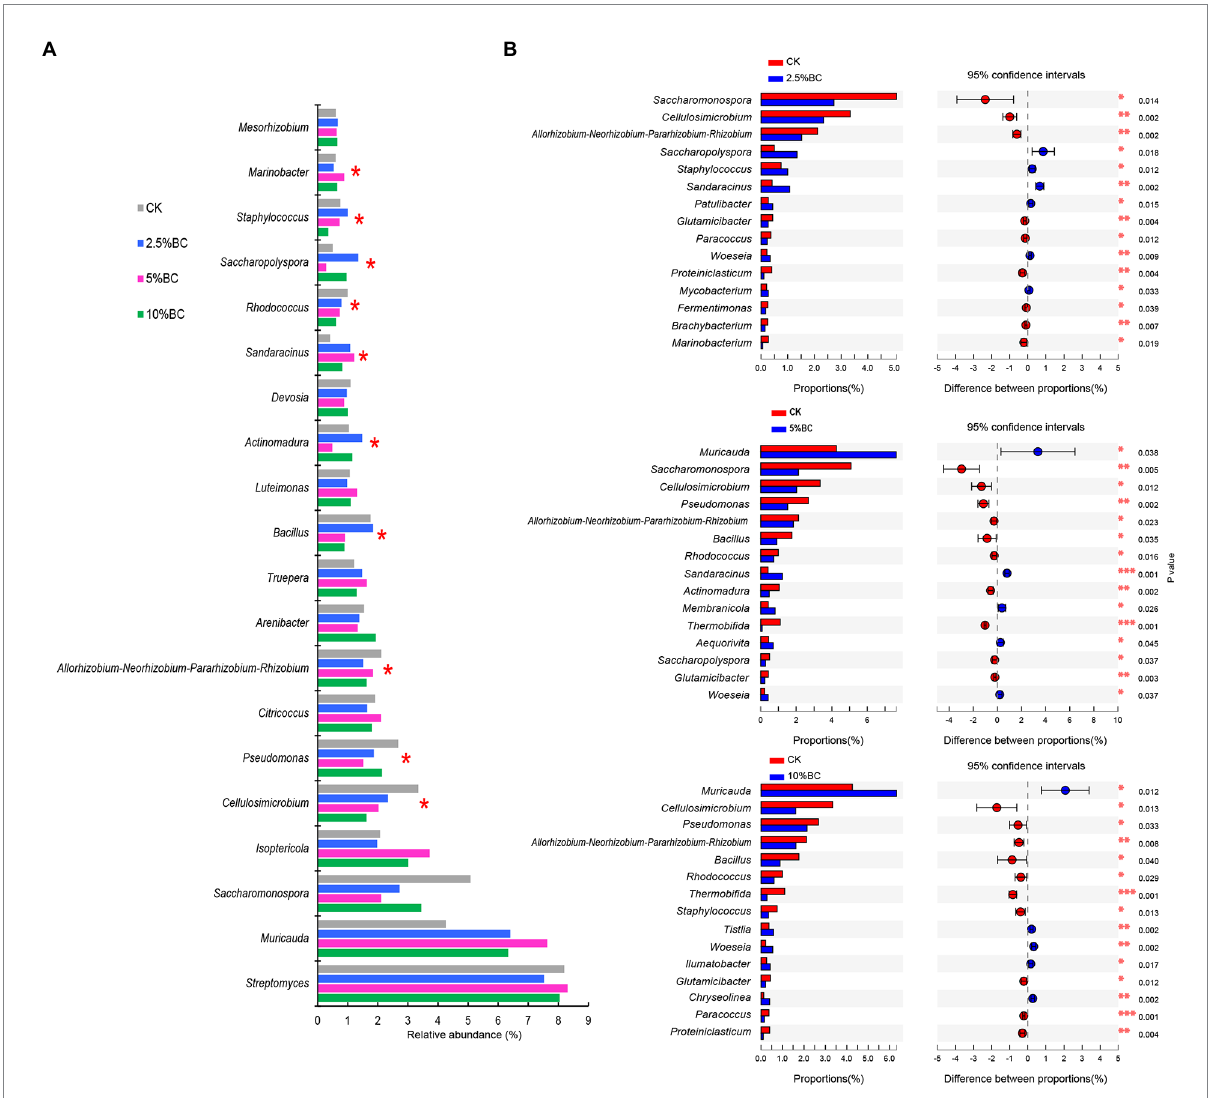
FIGURE 2 Effect of biochar on the bacterial relative abundance at genus level. (A) The relative abundance of top 20 dominant bacterial genera in different treatments. (B) Two group comparison based on genus level between CK and biochar addition treatment. CK, compost without biochar; 2.5%BC, compost added with 2.5% (w/w) biochar; 5%BC, compost added with 5% (w/w) biochar; 10%BC, compost added with 10% (w/w)